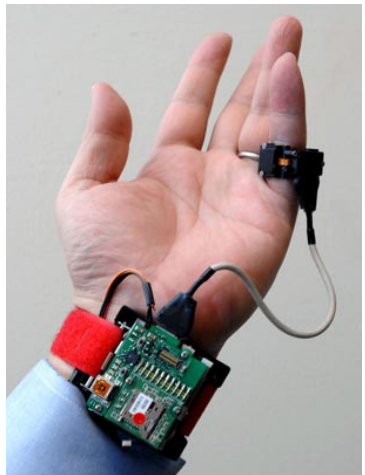
Figure 1. Blood pressure sensor by MIT